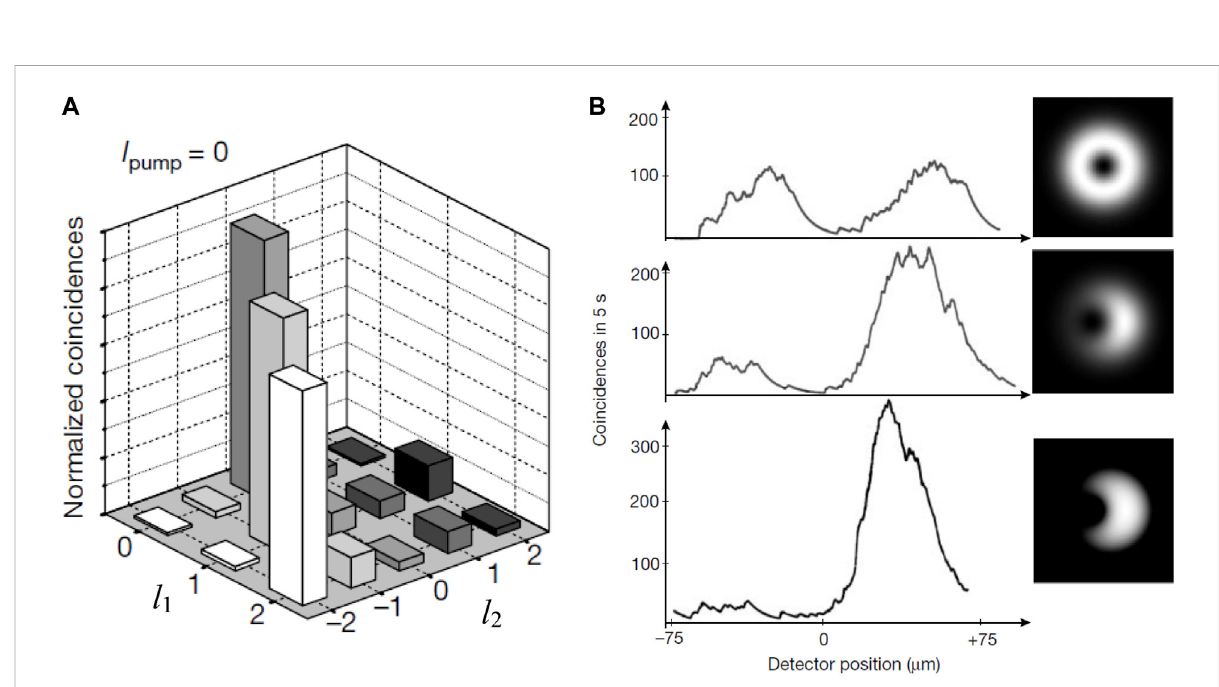
FIGURE 6 (A) Diagramsoftherelativenumbersofcoincidencesinchannels1and2; (B) experimentalcon fi rmationofentanglementofthephotonstatesin channels 1 and 2 [79] (cf. Figure